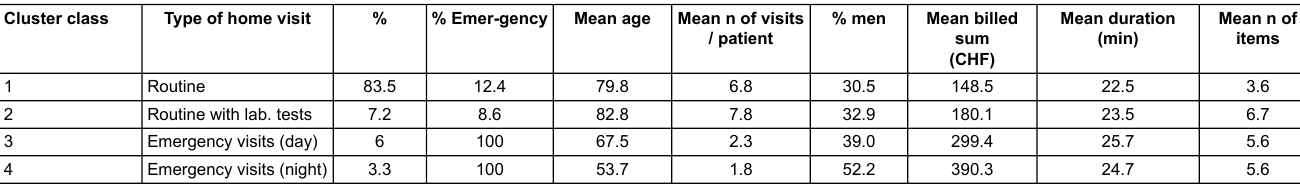
Table 2: Cluster class